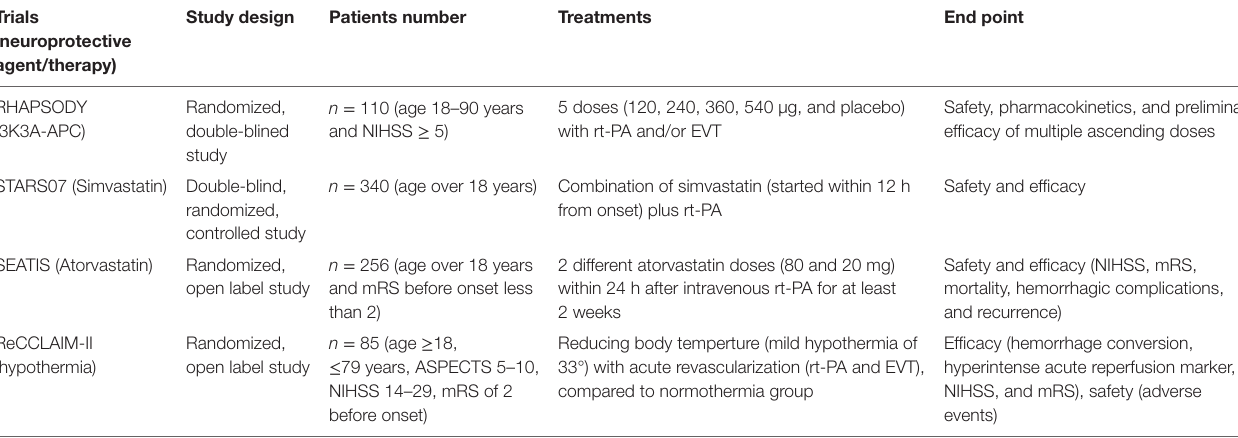
TAbLe 3 | Recent on going clinical trials of combined therapy with acute recanalization against ischemia-induced inflammation and reperfusion injury. Trials (neuroprotective